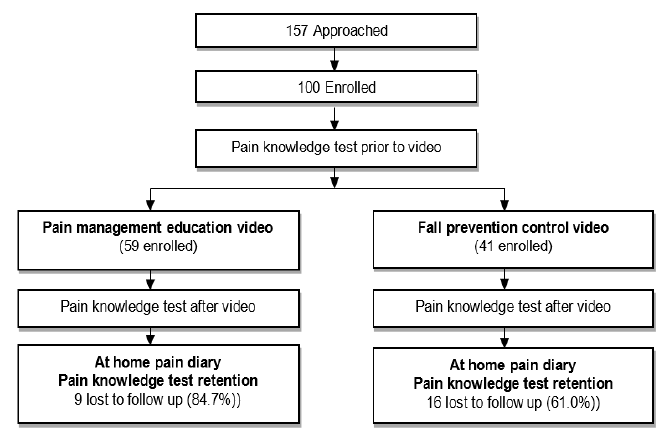
Figure. Summary of the study protocol.